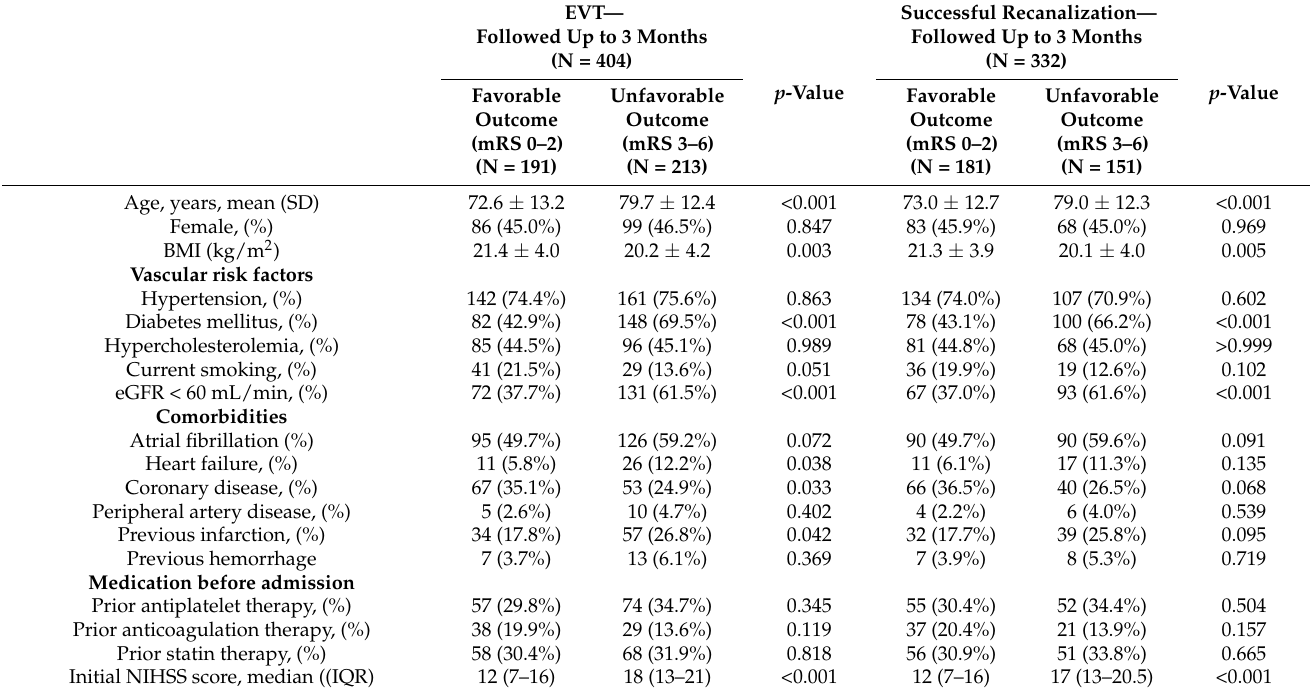
Table 1. Baseline characteristics correlated with mRS at 3 months in EVT patients and successful recanalization